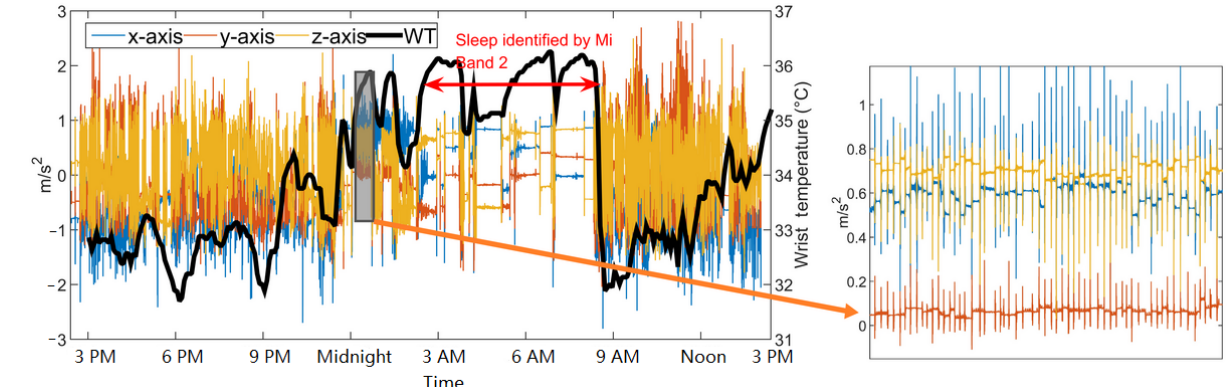
Figure 6. Example wrist temperature and AX3 data for a healthy older adult with irregular sleep (OA1). Sleep detected by the Mi Band 2 is indicated by the red double arrow. WT: wrist